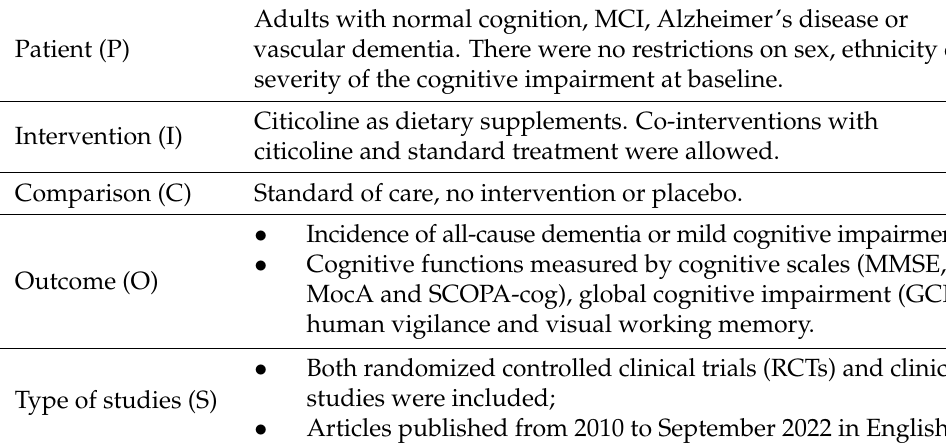
Table 1. Inclusion criteria based on PICO algorithm.